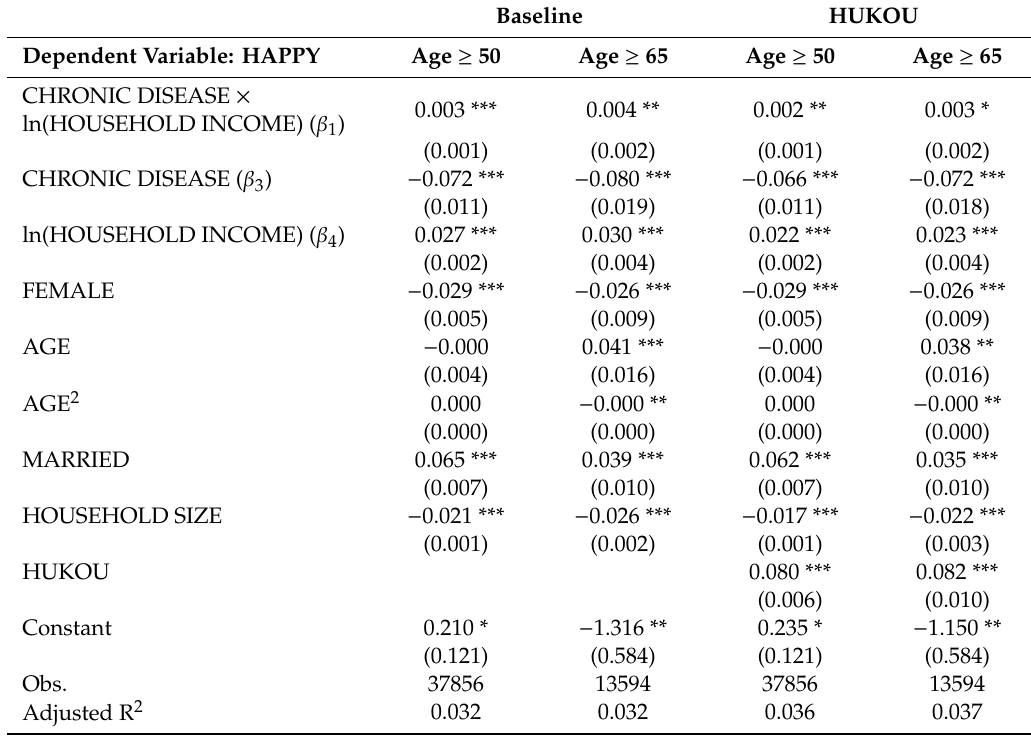
Table 10. With HUKOU